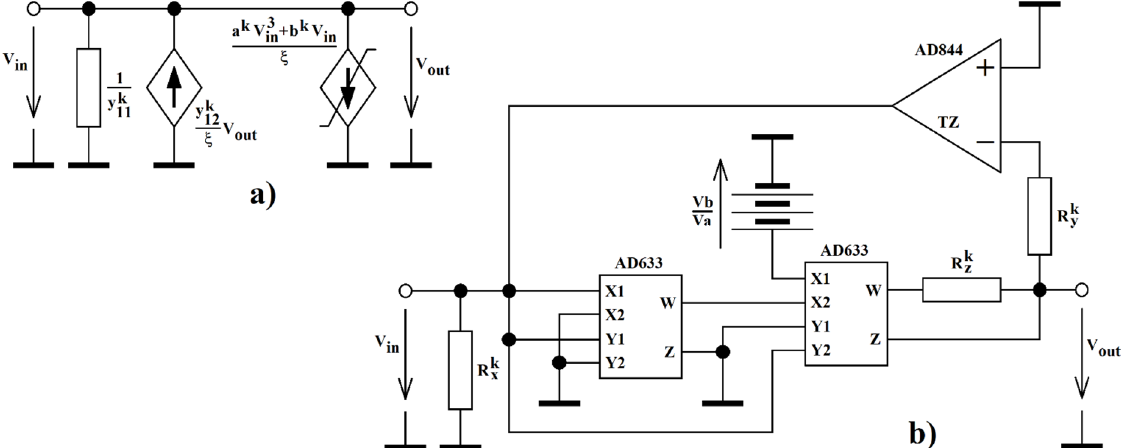
Figure 14. Generalized bipolar transistor designed based on optimization: ( a ) two-port equivalent network, ( b ) active circuitry implementation using commercially available integrated circuits.